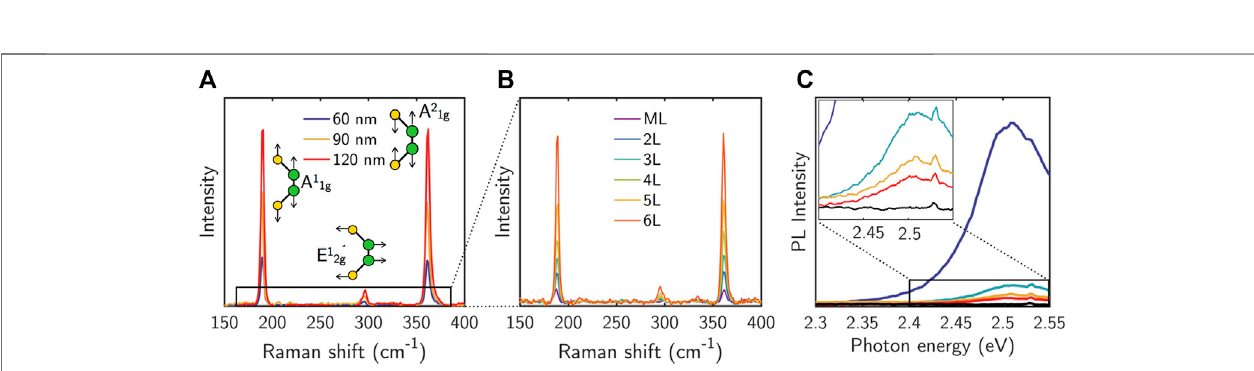
FIGURE 2 | Color evolution of GaS fl akes as a function of their thickness on (A) glass and on (B) 285-nm SiO 2 /Si substrates as determined according to the free- available code developed (Gutiérrez, 2021). The last image on the right is an example of an optical micrograph of a non-homogeneous exfoliated fl ake, with the different colors corresponding to different number of layers.